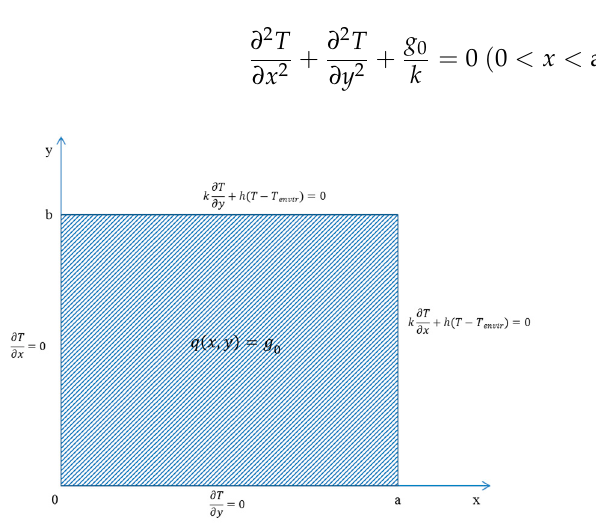
Figure 6. Heat conduction problem with uniform internal heat source.